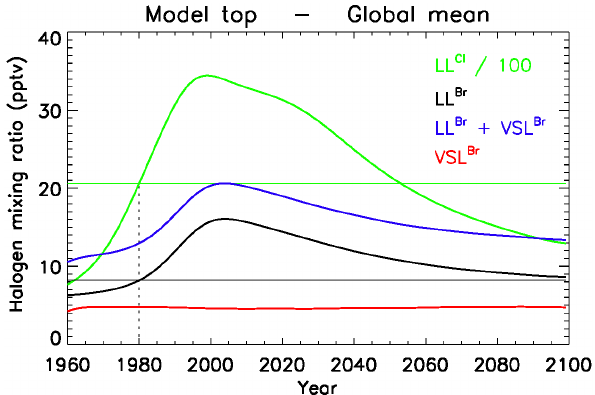
Figure 1. Temporal evolution of the annual mean global strato- spheric halogen loading at the top of the model (i.e. 3.5hPa) for long-lived chlorine (LL Cl ) and bromine (LL Br ) , as well as very short-lived bromine (VSL Br ) . The horizontal lines indicate the LL Cl and LL Br mixing ratio for 1980. LL Cl mixing ratios were divided by 100.